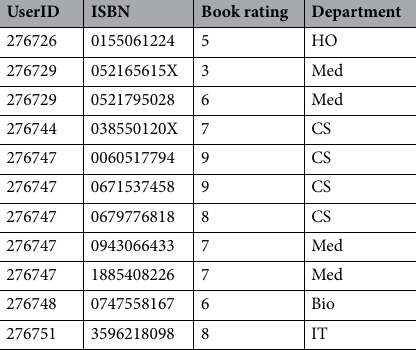
Table 1. Books dataset information.